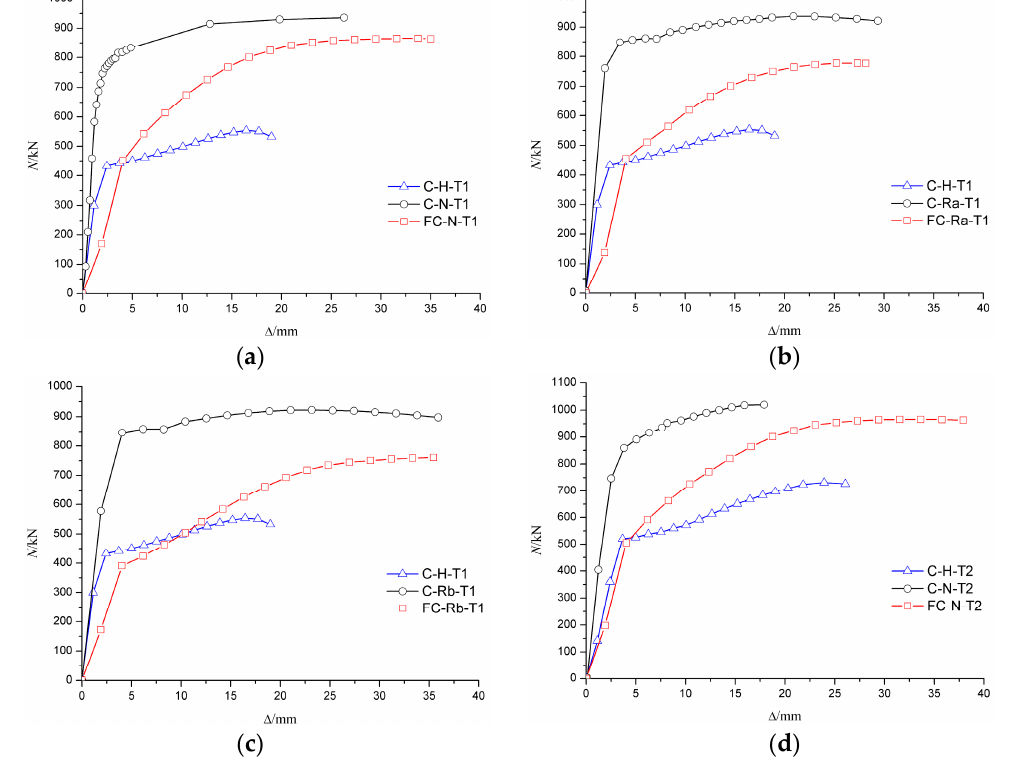
Figure 25. Load–deformation curves of specimens before and after fire. ( a ) Fine aggregate concrete (wall thickness is 4 mm); ( b ) Recycled aggregate concrete-Ra (wall thickness is 4 mm); ( c ) Recycled aggregate concrete-Rb (wall thickness is 4 mm); ( d ) Fine aggregate concrete (wall thickness is 5 mm).